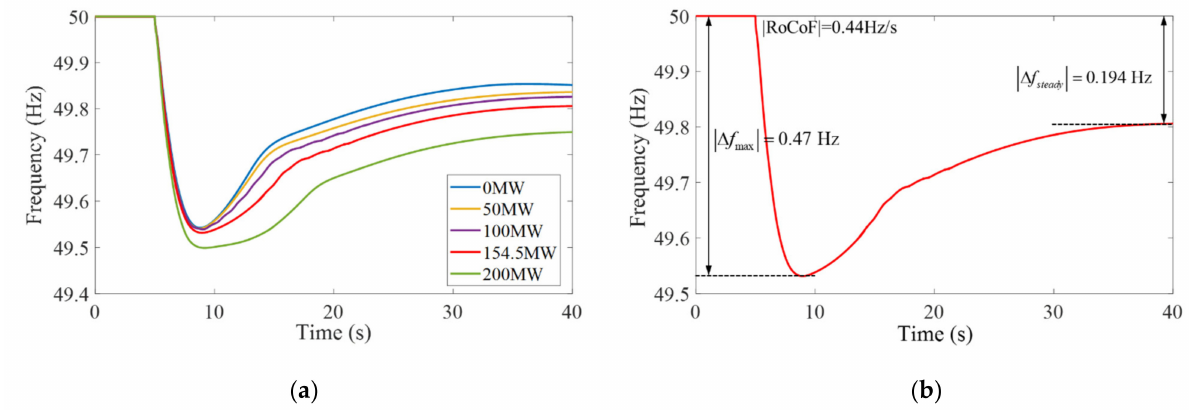
Figure 6. System frequency curves after one thermal unit in HB plant trips; ( a ) With increasing capacity of wind power integration; ( b ) With the wind power integration of 154.5 MW.